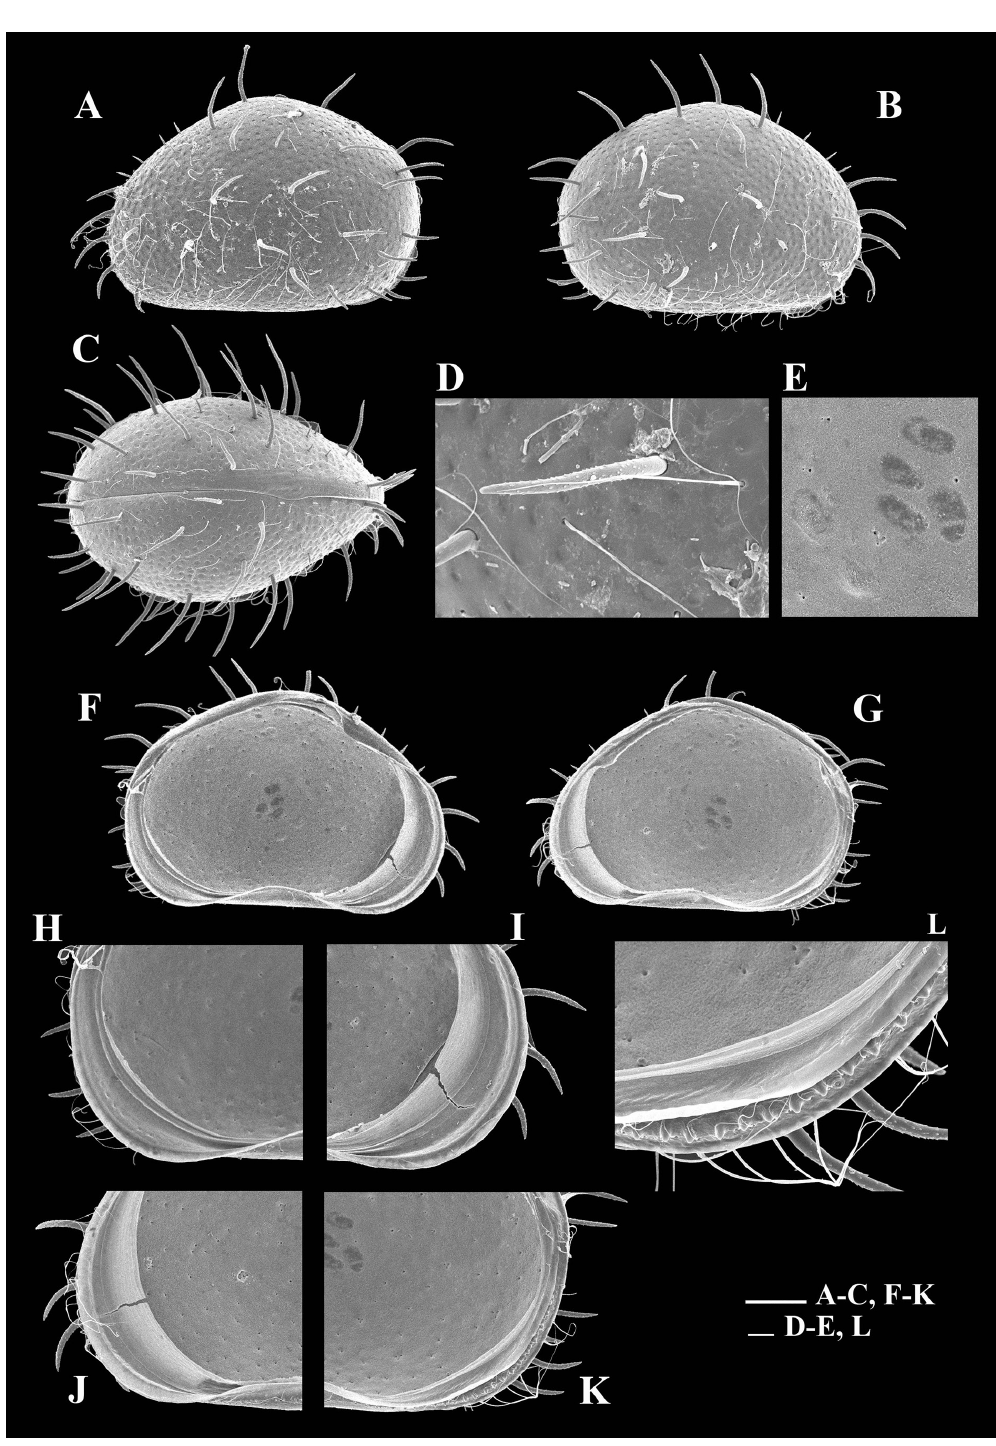
Fig. 1. Thaicypridopsis longispinosa sp. nov., ♀♀. A. LVe (MSU-ZOC.257). B. RVe (idem). C. CpD (MSU-ZOC.259). D. Valve surface (MSU-ZOC.257). E. Muscle scars of RV (MSU-ZOC.258). F. LVi (idem). G. RVi (idem). H. Posterior part of LVi (idem). I. Anterior part of LVi (idem). J. Anterior part of RVi (idem). K–L. Posterior part of RVi (idem). Scale bars: A–C, F–G = 100 µm; D, L = 10 µm; E = 13 µm; H–K = 58